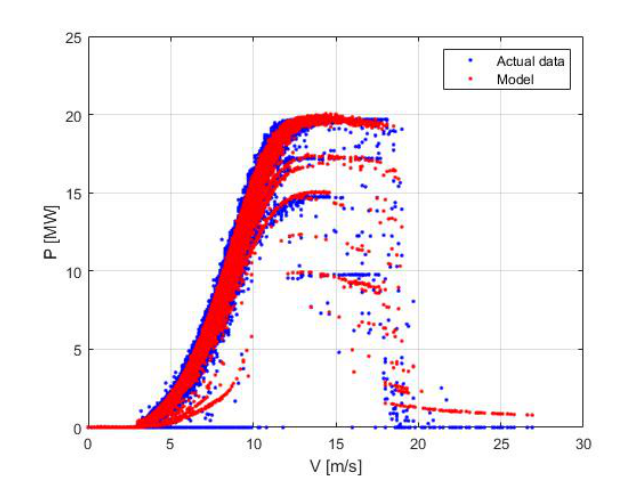
Figure 17. Data as measured and forecast of energy production from wind power plant FW1.